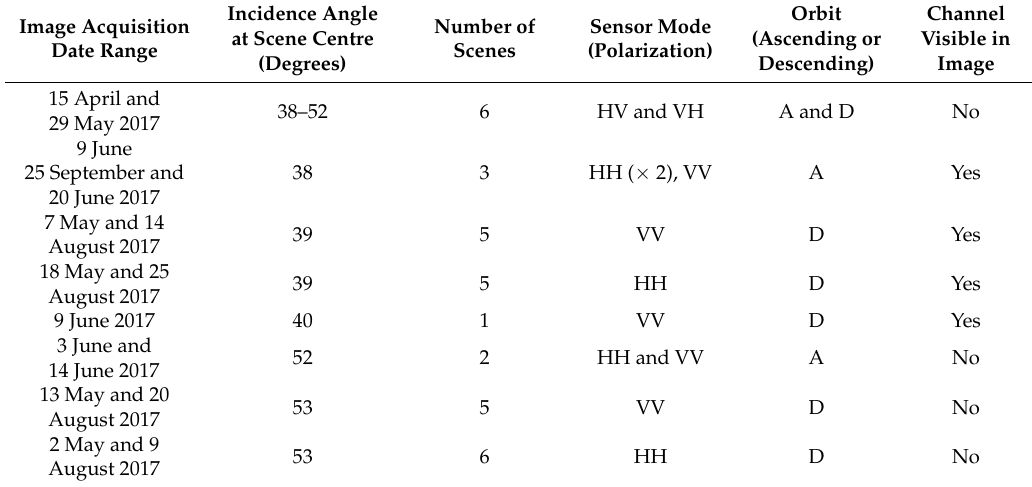
Table 1. Product Specifications of TanDEM-X bistatic acquisitions (German Aerospace Center (DLR)) used in the analysis. All scenes were acquired in the 300 MHz High Resolution spotlight mode, right looking, with a range and azimuth resolution of 0.6 m × 1.1 m, resulting in a processed pixel spacing of 0.87 m–1.14 m (dependent on the incidence angle).